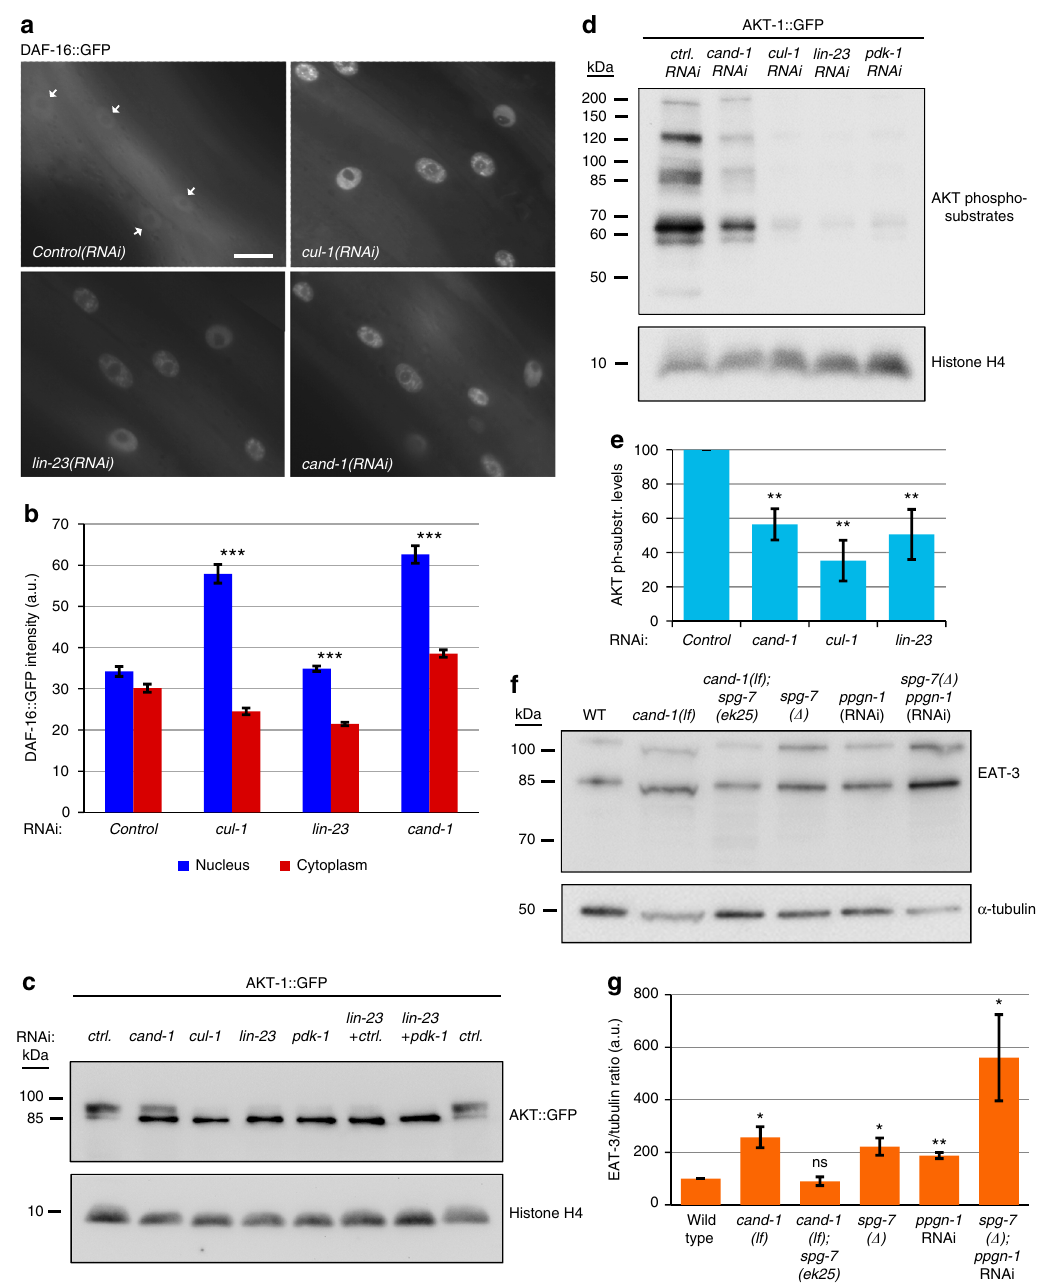
Fig. 2 CAND-1/SCF LIN-23 activates AKT-1 to inhibit DAF-16 and reduce EAT-3 levels. a DAF-16::GFP nuclear localization in body-wall muscle cells for animals with the indicated RNAi treatments. White arrows indicate nuclei in the control RNAi image. Scale bar , 10 µ m. b Quanti fi cation of the mean level of nuclear and cytoplasmic DAF-16::GFP intensity in body-wall muscle cells. Error bars denote s.e.m. P values were determined by Student ’ s t -test. Sample size ( n ) of body-wall muscle cells from left to right are: 44; 61; 102; 87. c Western blot with anti-GFP of AKT-1::GFP from whole-animal lysate of L4/young-adult-stage animals treated with the indicated RNAi showing the altered mobility of AKT-1::GFP on SDS-PAGE; anti-histone H4 staining is used as a loading control. Similar results were obtained in two to fi ve biological replicates. d Western blot showing staining for an antibody that recognizes AKT phospho-substrates in animals expressing AKT-1::GFP and subjected to the indicated RNAi treatments. Signi fi cant decreases in AKT phospho-substrates were observed for cand-1 , cul-1 , and lin-23 RNAi conditions in three to fi ve biological replicates, with pdk-1 RNAi shown as a control that is known to reduce AKT-1 activity. The identities of the AKT-1 phospho-substrate proteins observed in the western blot are not known. e Graph showing the levels of AKT phospho-substrate signal relative to control protein bands (anti-tubulin or anti-histone H4) for three to fi ve biological replicates. The control RNAi is set to 100 in arbitrary units. Error bars denote s.e.m. P values were determined by Student ’ s t -test. f Western blot showing EAT-3 protein levels for the indicated genotypes and RNAi treatments. The expected molecular weights of the L-isoform and S-isoform of EAT-3 are 110.1 and 85.5 – 86.4 kDa, respectively. g Quanti fi cation of EAT-3 levels normalized to α -tubulin. Error bars denote s.e.m. from two to four biological replicates. For all panels, asterisks above bars denote P value comparisons to wild type/controls; asterisks above lines denote comparisons under the lines: * P < 0.05; ** P < 0.01; *** P < 0.001; ns = not signi fi